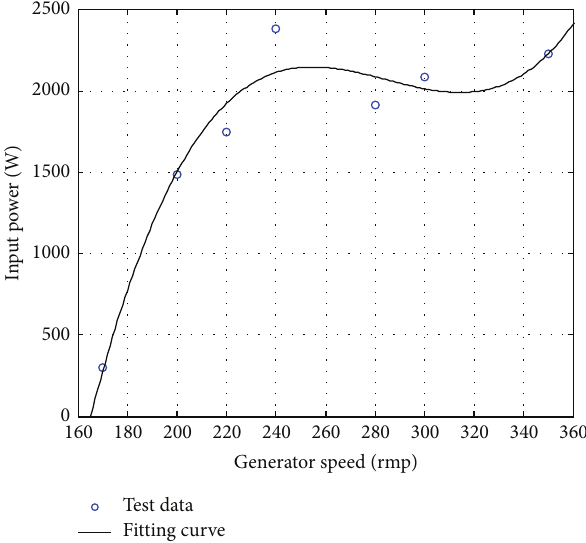
Figure 13: The input power of Buck converter versus generator speed at 10